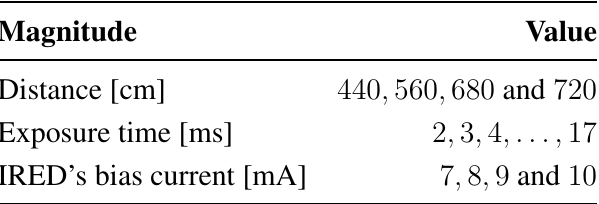
Table 1. Data used in the calibration process.